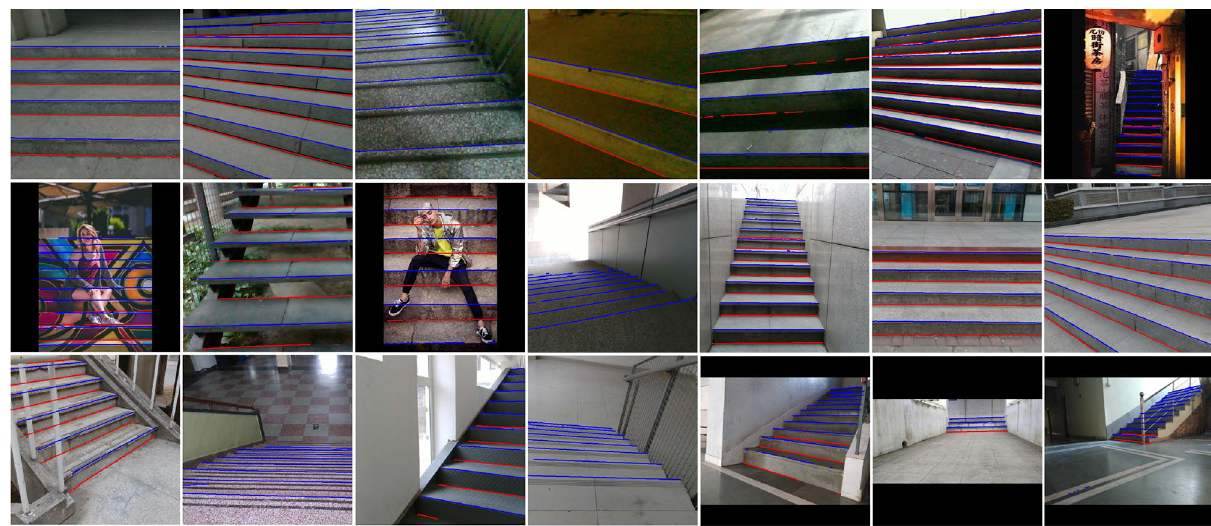
Figure 7. Partial visualization results produced by StairNet 1 × on the validation